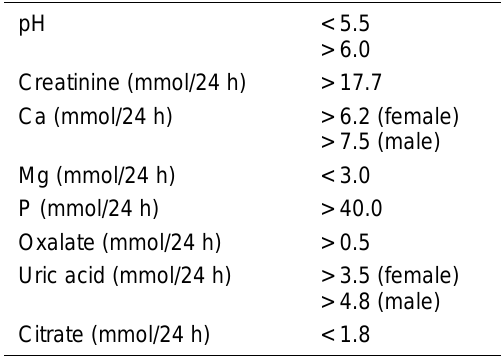
Urinary Metabolic Risk Reference Values in